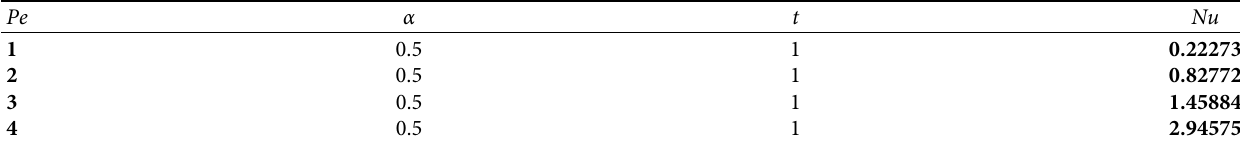
Table 1: Variation in the Nusselt number for diferent values of Pe .